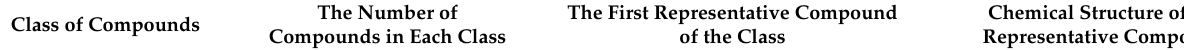
Table 1. Classification of phytocannabinoids. Adapted from [9], MDPI, 2021.